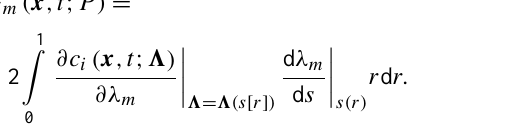
The sum of the source contributions on the three paths was compared to the anthropogenic concentration increment (right- vs. left-hand sides of Eq. 1) to determine the accuracy of the formulas. Table 2 gives the mean absolute error and mean bias of the formulas for O 3 and FORM, and Table